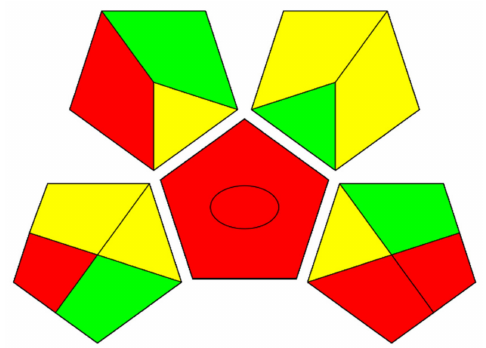
Figure 6. GAPI pictogram for the SI-HLLME-HPLC-DAD